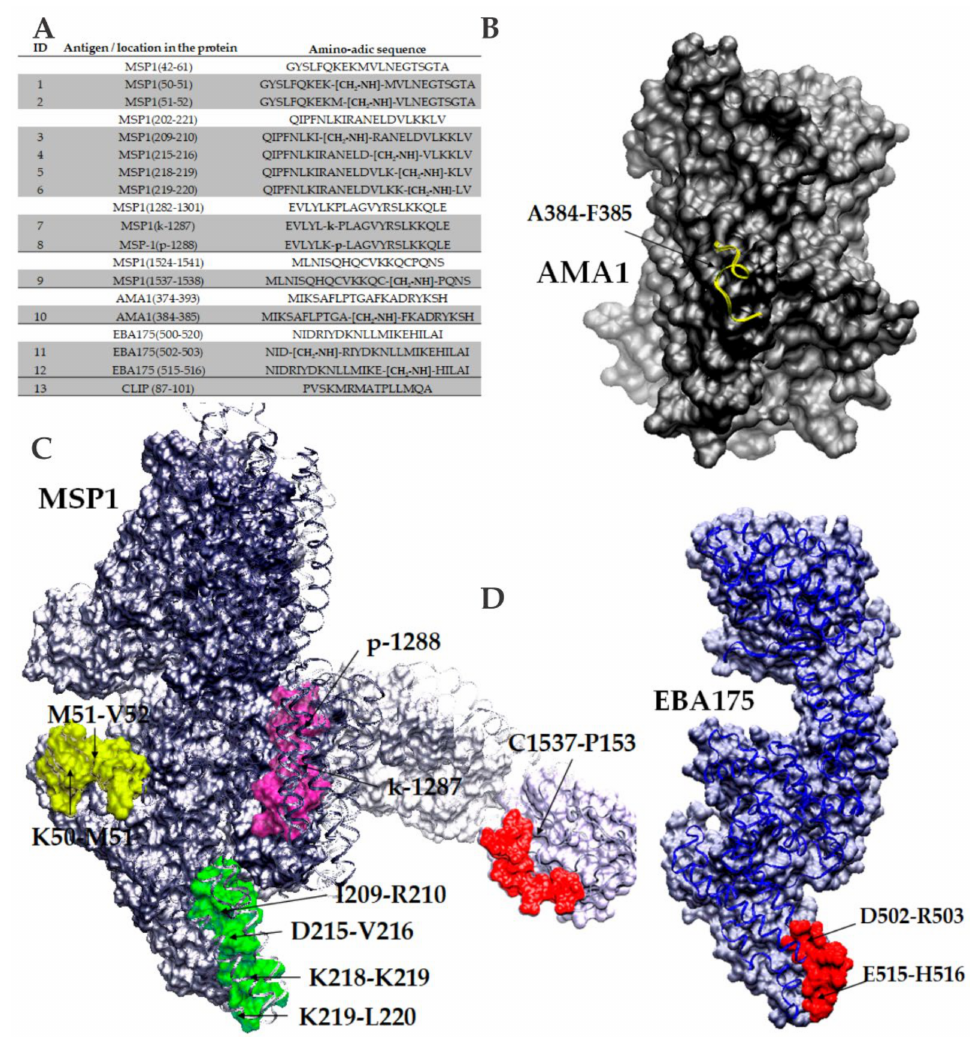
Figure 3. ( A ) P. falciparum blood-stages protein targets, amino-acid sequences, and modified analogs. ( B ) Localization of the AMA1 antigen-epitope highlighted in yellow ribbons and its key modified peptide-bond. ( C ) N -terminus MSP1 3D structure modelized from a predicted model generated by I-Tasser. C -terminal MSP1 fragment pdb file 1ob1 code was employed. Structure recreation shows all peptides sequences. ( D ) Localization of one EBA175 antigen-epitope highlighted in red ribbons and its two key modified peptide-bonds are denoted with arrows. Protein and epitope modeling and personalization were performed with the VMD 1.9.3 version software, from